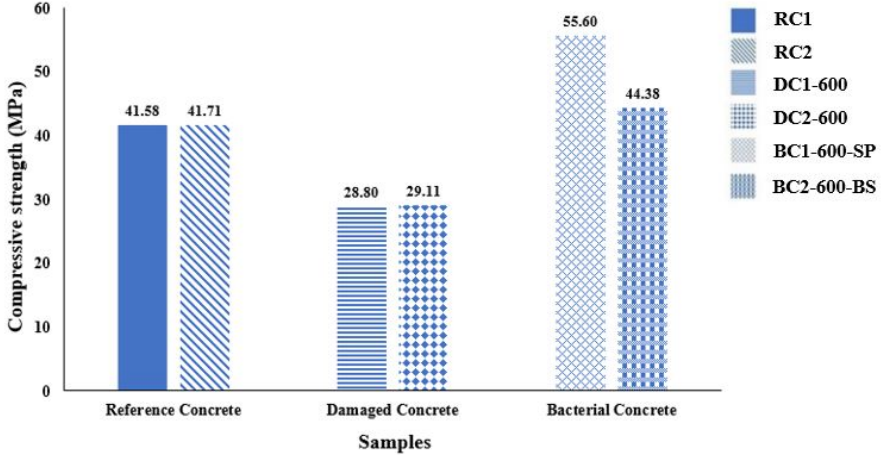
Figure 4. Comparing compressive strength results of the control specimens, damaged at 600 °C and repaired by type I and II bacteria.